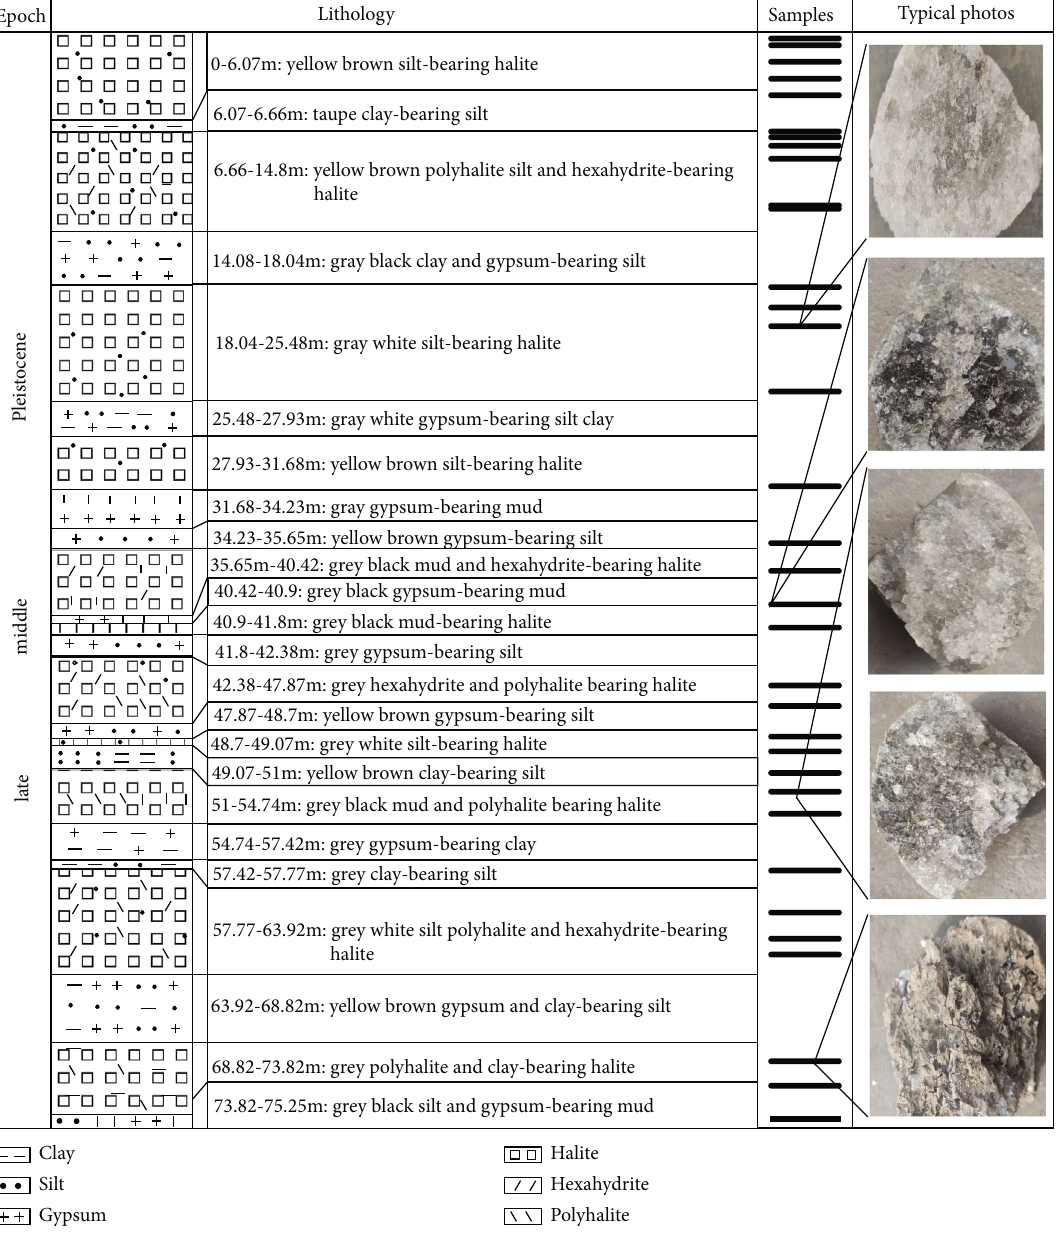
Figure 2: ZK3608 lithology description, sampling point location, and typical hand